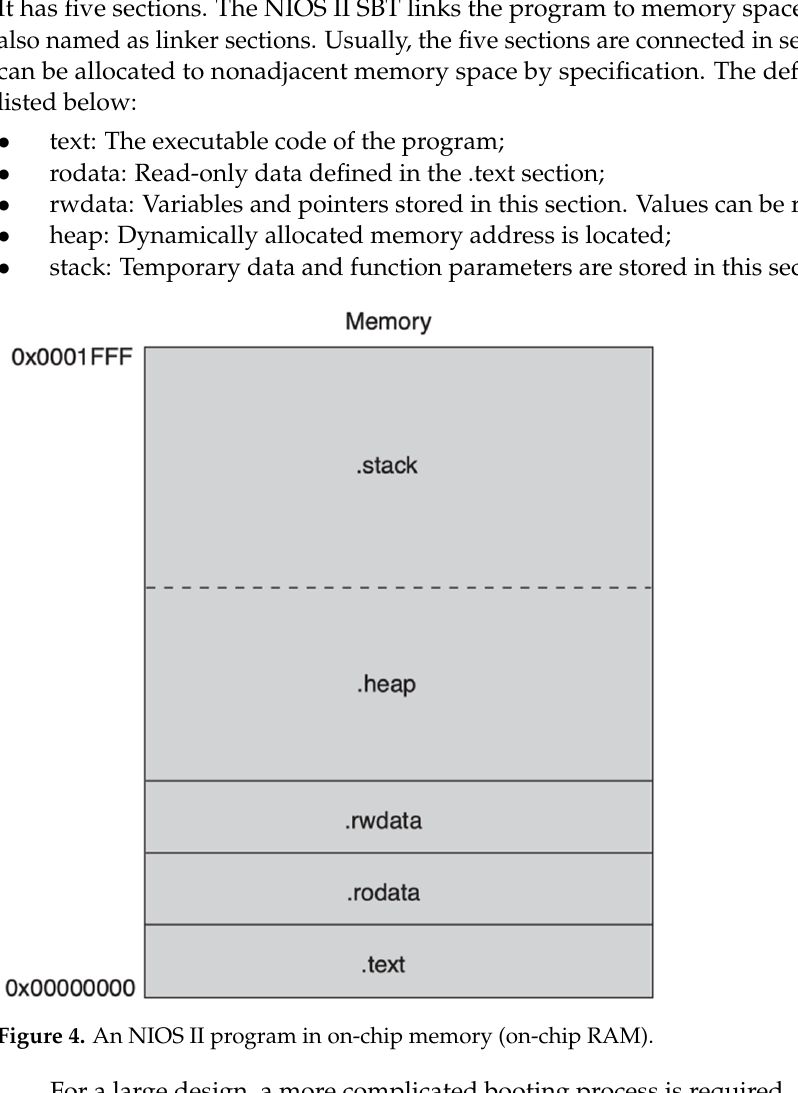
Figure 4. An NIOS II program in on-chip memory (on-chip RAM).